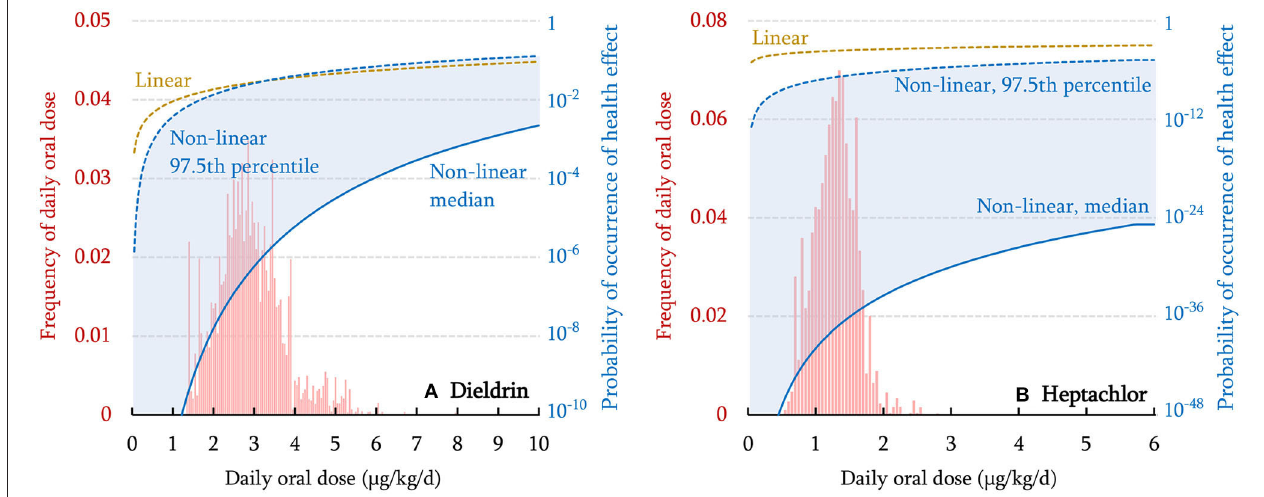
FIGURE 2 | Distribution of modeled daily oral dose within the virtual population (histogram in red), the linear dose-response relationship (dashed curve), non-linear dose-response relationship with homogeneous susceptibility (median) across the population (solid curve), and non-linear dose-response relationship with individual-specific heterogeneous susceptibility (97.5th percentile shown in shadow) for dieldrin (A) and heptachlor (B) . Note that the probability of occurrence of health effects is displayed on a logarithmic scale. The curve representing the 2.5th percentile is too low to be shown.